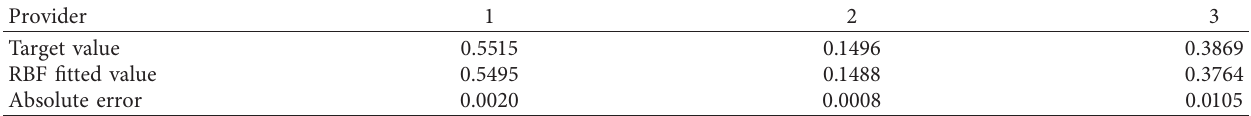
Table 10: The comprehensive score results of cruise ship supply